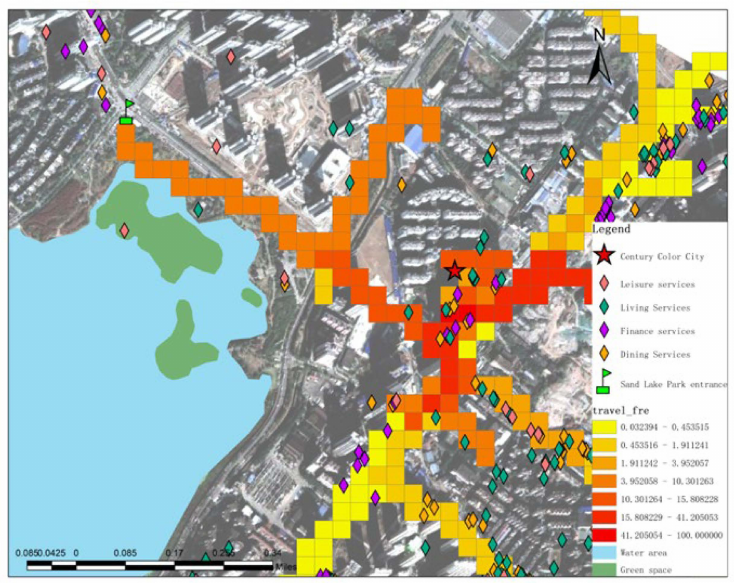
Figure 14. Spatial mismatch